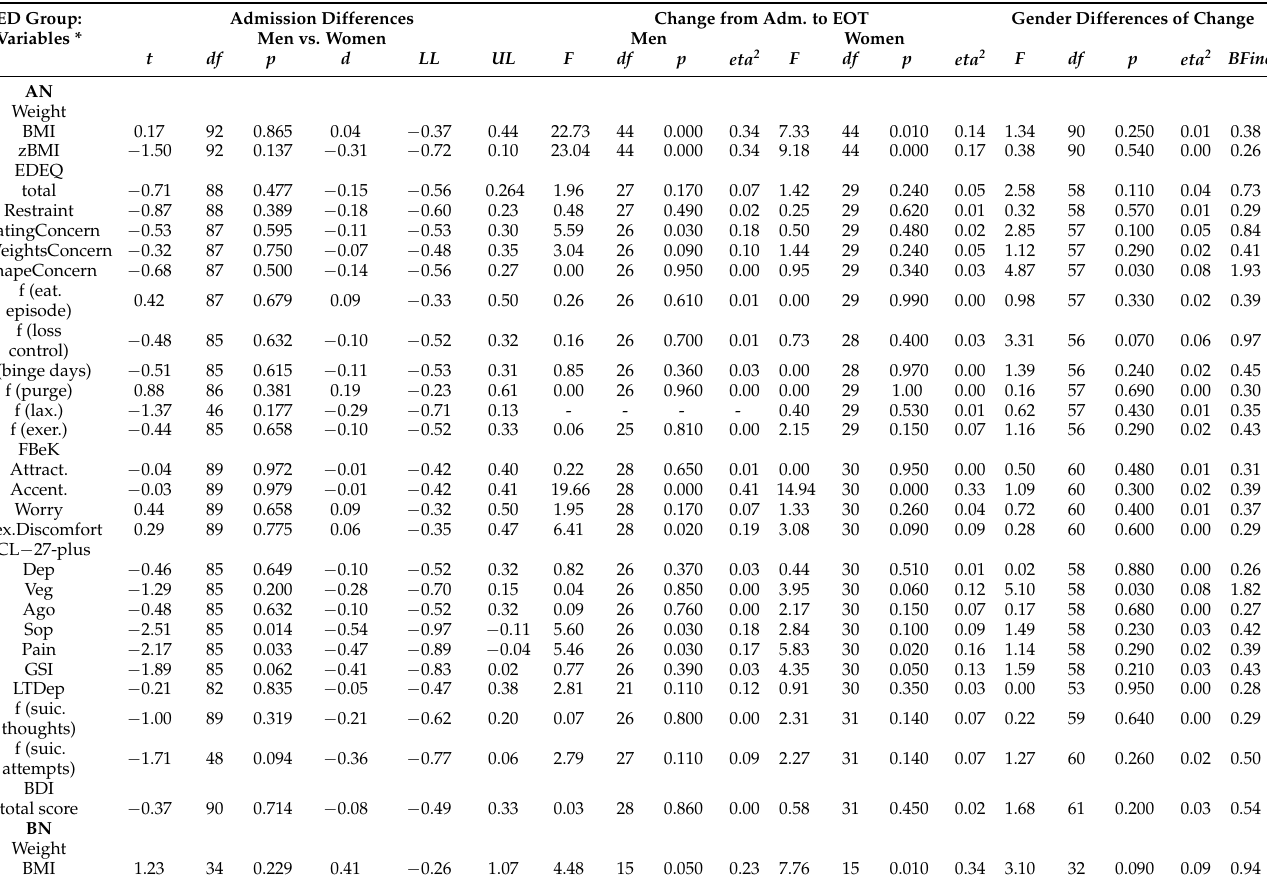
Table A2. Outcome measures inferential